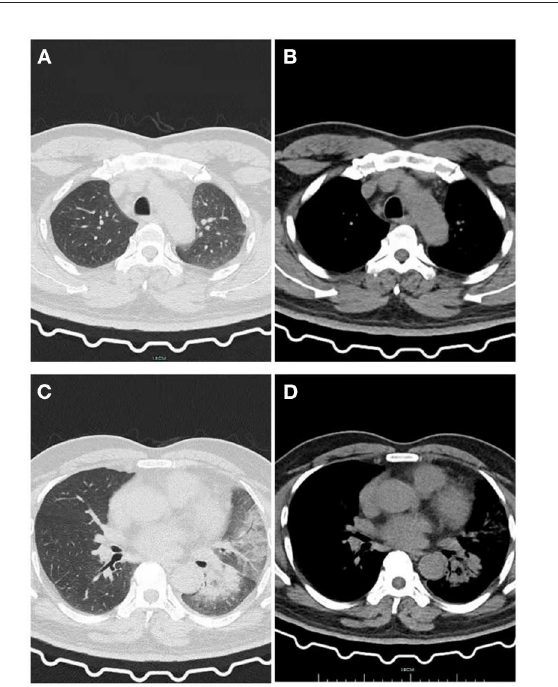
FIGURE1 Image of the patient’s first CT inspection on June 5, 2021. (A) Lung window: Patchy high-density shadow in the upper lobe of the left lung with blurred edges. (B) Mediastinal window: Patchy exudative lesions in the upper lobe of the left lung. (C) Lung window: No obvious exudative lesions in the left lower lobe, and a small amount of pleural effusion on the left. (D) Mediastinal window: No obvious exudative lesions.